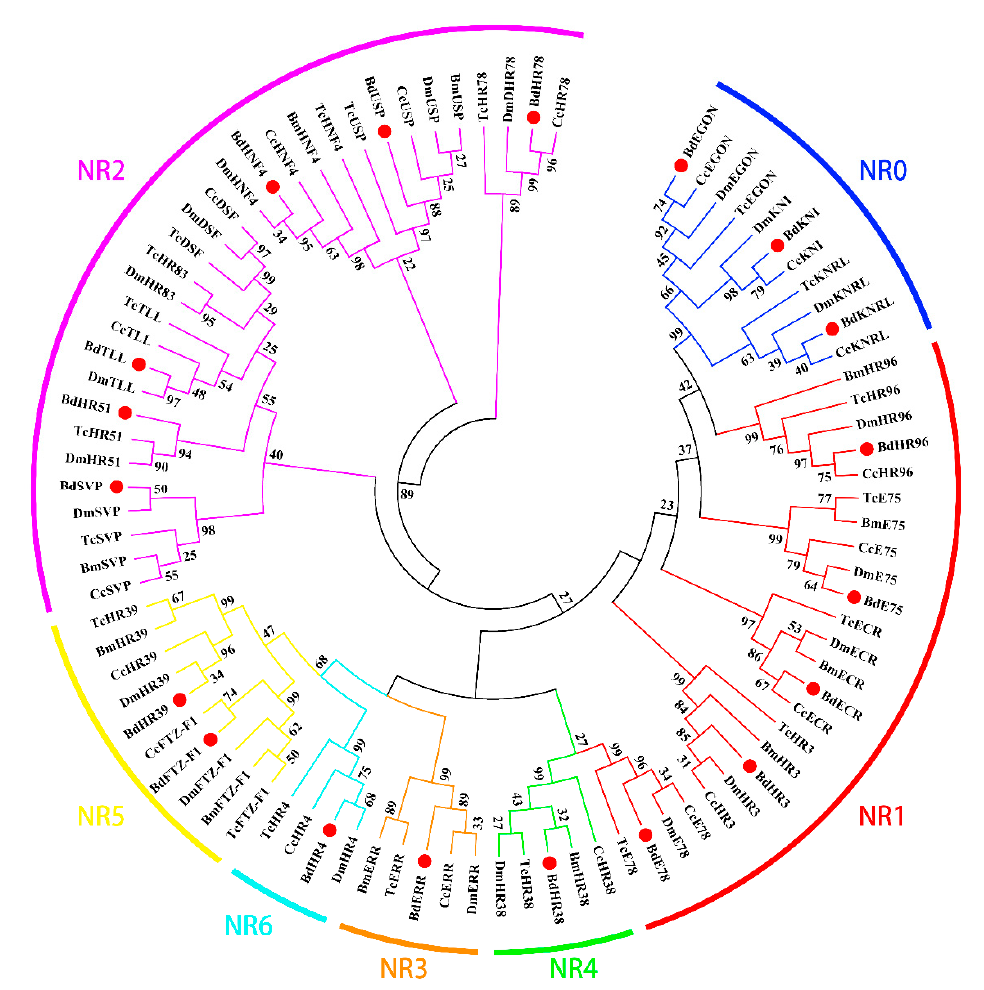
Figure 2. Phylogenetic analysis of 90 insect nuclear receptor (NR) proteins from five different species. Bombyx mori (Bm), Ceratitis capitata (Cc), Bactrocera dorsalis (Bd), Drosophila melanogaster (Dm) and Tribolium castaneum (Tc). A bootstrap analysis of 1000 replications was carried out on the trees inferred using the neighbor-joining method, and bootstrap values were shown at each branch of the tree. NRs from B. dorsalis are indicated by red dots.